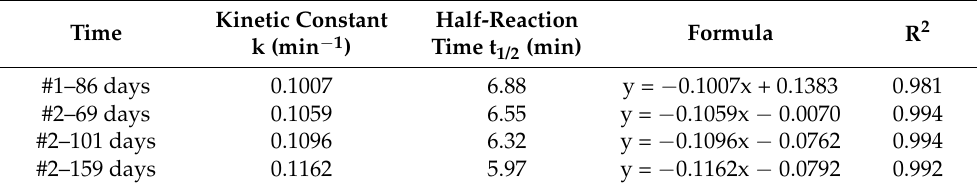
Table 5. Linear regression analysis of biological ammonia removal at different